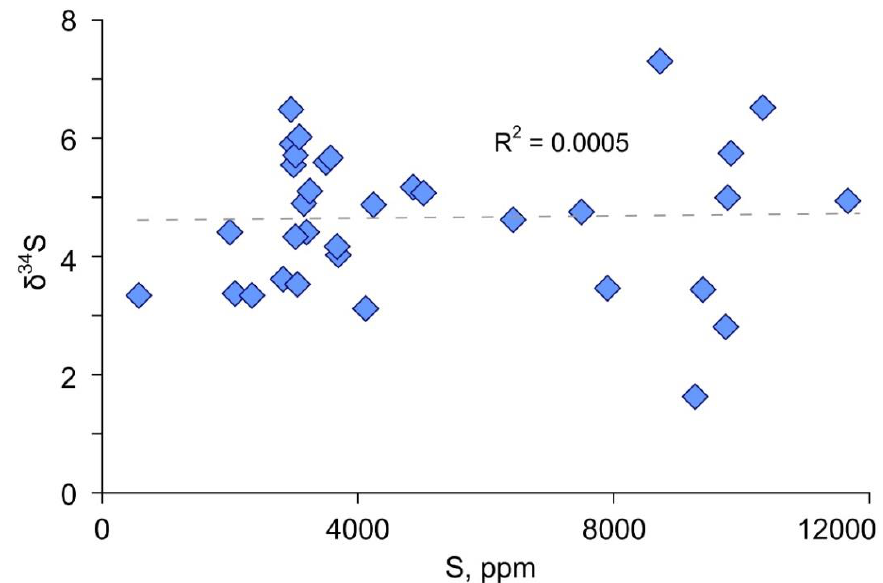
Figure 4. Variation diagram δ 34 S vs. S content, ppm. Zero correlation is visible for the concentration range of sulfur spanning orders of magnitude.